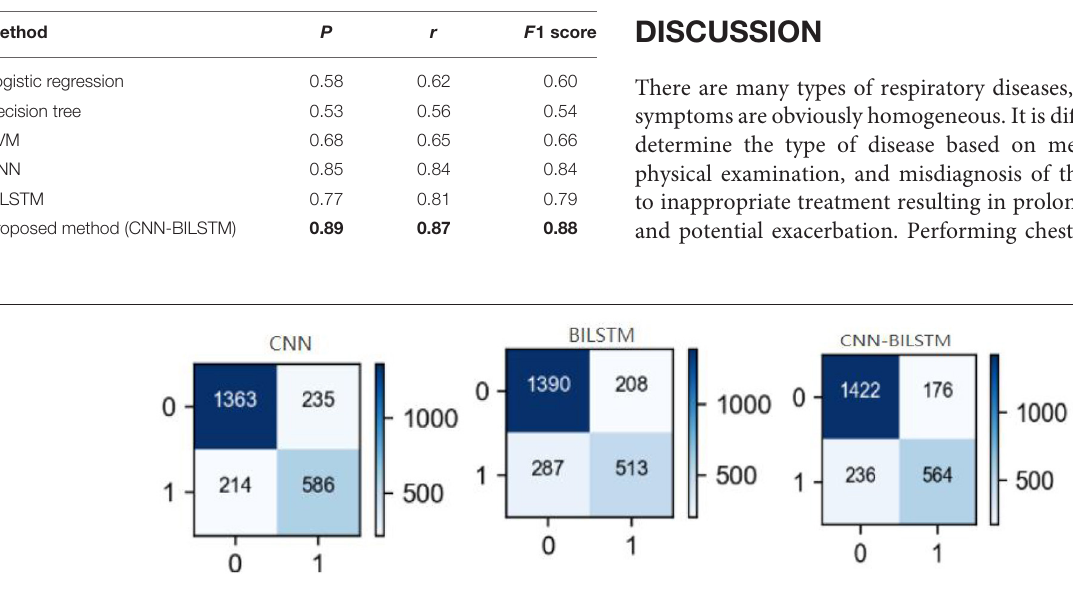
FIGURE 8 | Confusion matrices of each method. Horizontal is predicted value, vertical is actual value, “0” is negative, “1” is positive.